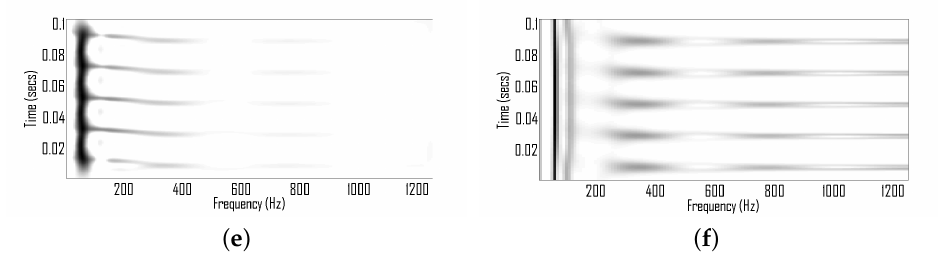
Figure 7. TF plots of a real world signal acquired from iron having spikes. ( a ) Spectrogram (hamming window of length 45); ( b ) reassigned Spectrogram; ( c ) MBD ( β = 0.1 and lag window of length 64); ( d ) Gabor Wigner transform (Gabor transform of window length 45 is used); ( e ) the adaptive TFD ( a = 3 and b = 8); and ( f ) the S-transform.